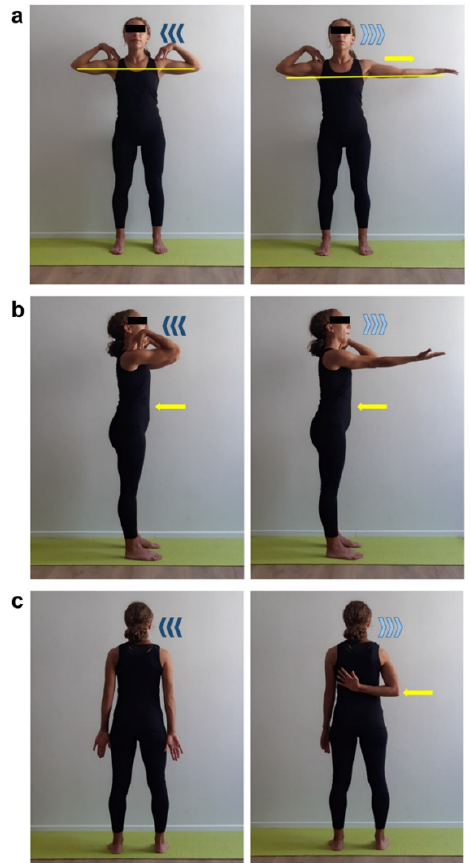
Figure 6. Shoulders mobilization exercise paired to breathing. Supine position, flexed legs, set straight arms by body sides with relaxed shoulders, holding a stick without forcing the grip. Inhale (dark blue arrows), exhale (light blue arrows) and simultaneously flex straight arms upward (yellow arrow) and get back to start position. During exhalation phase focus on keeping the spine in touch with the floor without lifting thorax (yellow arrow). Two sets of 10 repetitions, 30 s recovery.